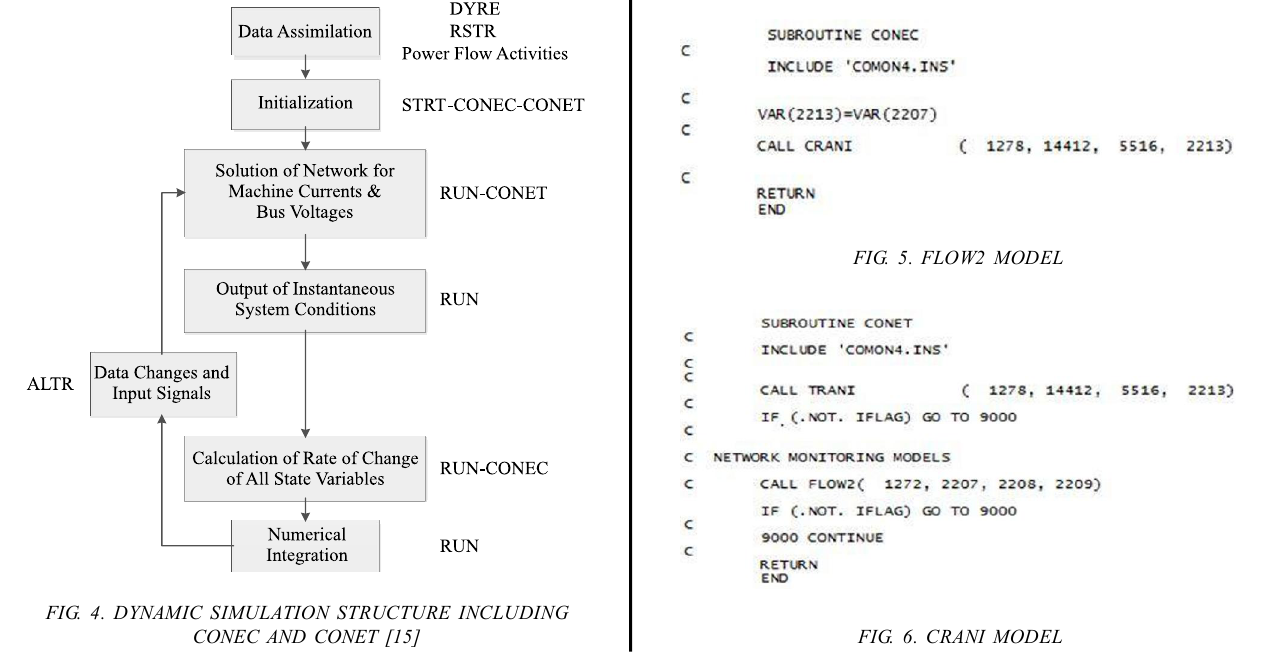
FIG. 4. DYNAMIC SIMULATION STRUCTURE INCLUDING CONEC AND CONET